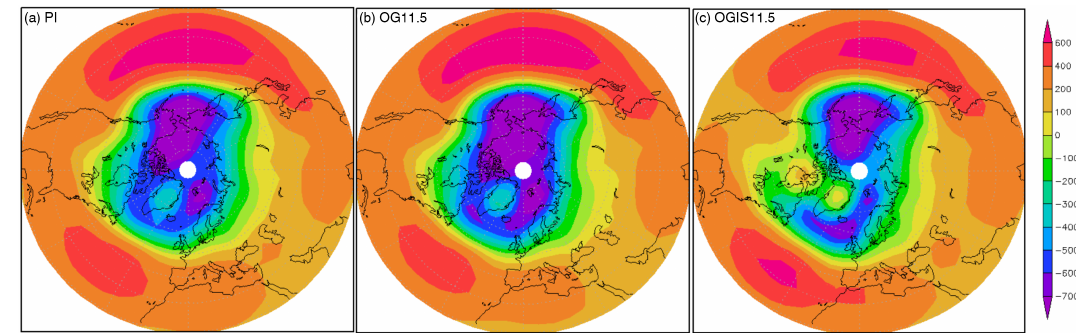
Figure 10. Geopotential height anomalies from global mean (in m 2 s − 2 ) at 800hPa in the extratropical Northern Hemisphere. Panels (a) , (b) and (c) show the control condition PI and the simulations OG11.5 and OGIS11.5, respectively.